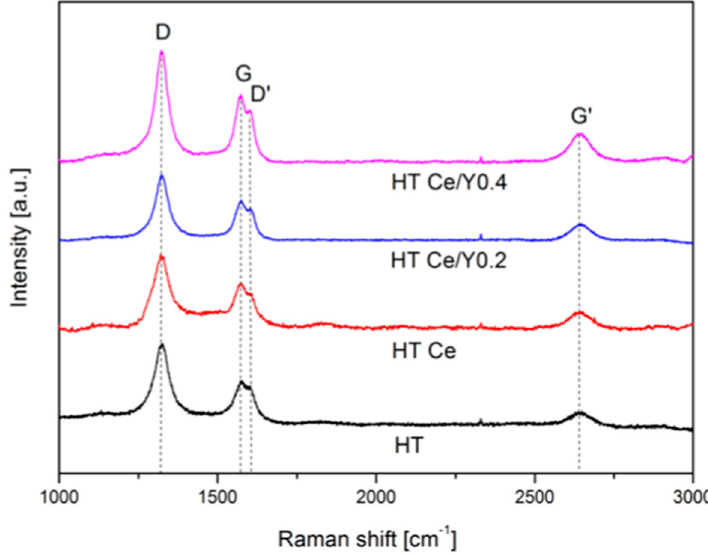
Figure 10. Raman spectra recorded for the spent catalysts.